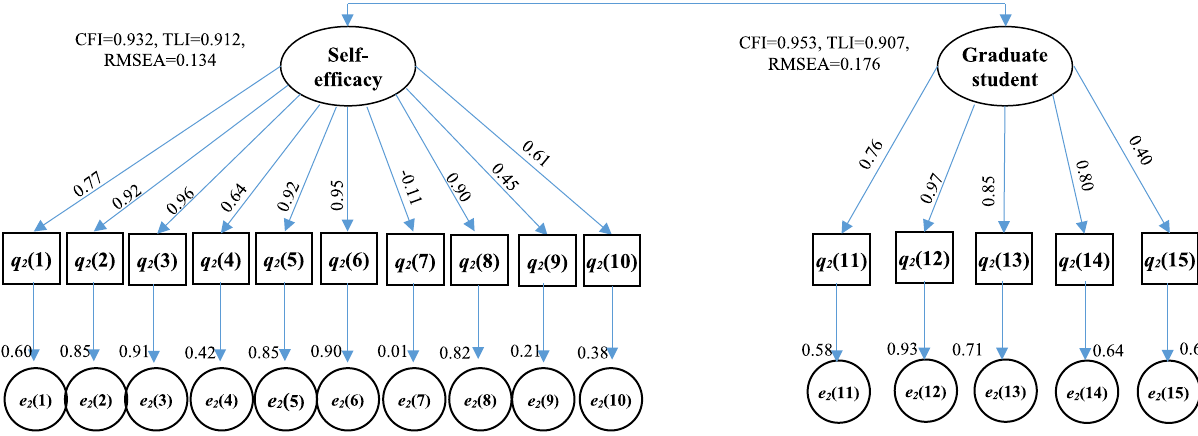
Fig. 3 Structural equation model describing the perceptions of teacher on the roles played by themselves and graduate students for the GTA’s